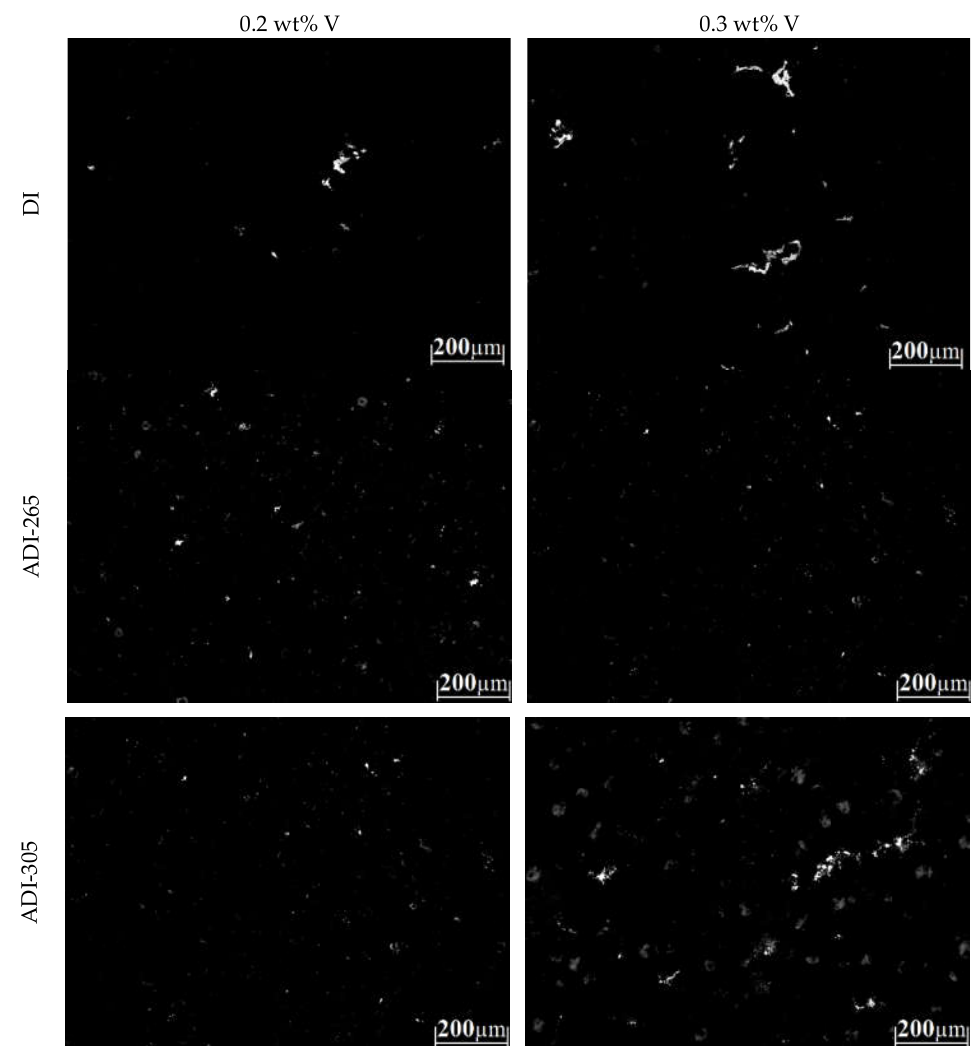
Figure 10. Etched microstructure with ammonium persulfate revealed the carbide phases (white regions) of the DIs and ADIs low alloyed with vanadium.